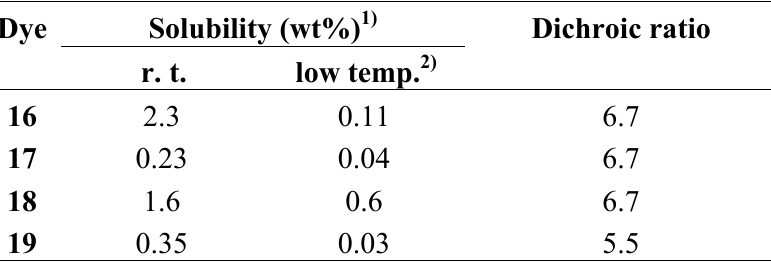
Table 5. Solubilities and dichroic ratios of magenta anthraquinone dyes with two anilino groups at 1 and 5